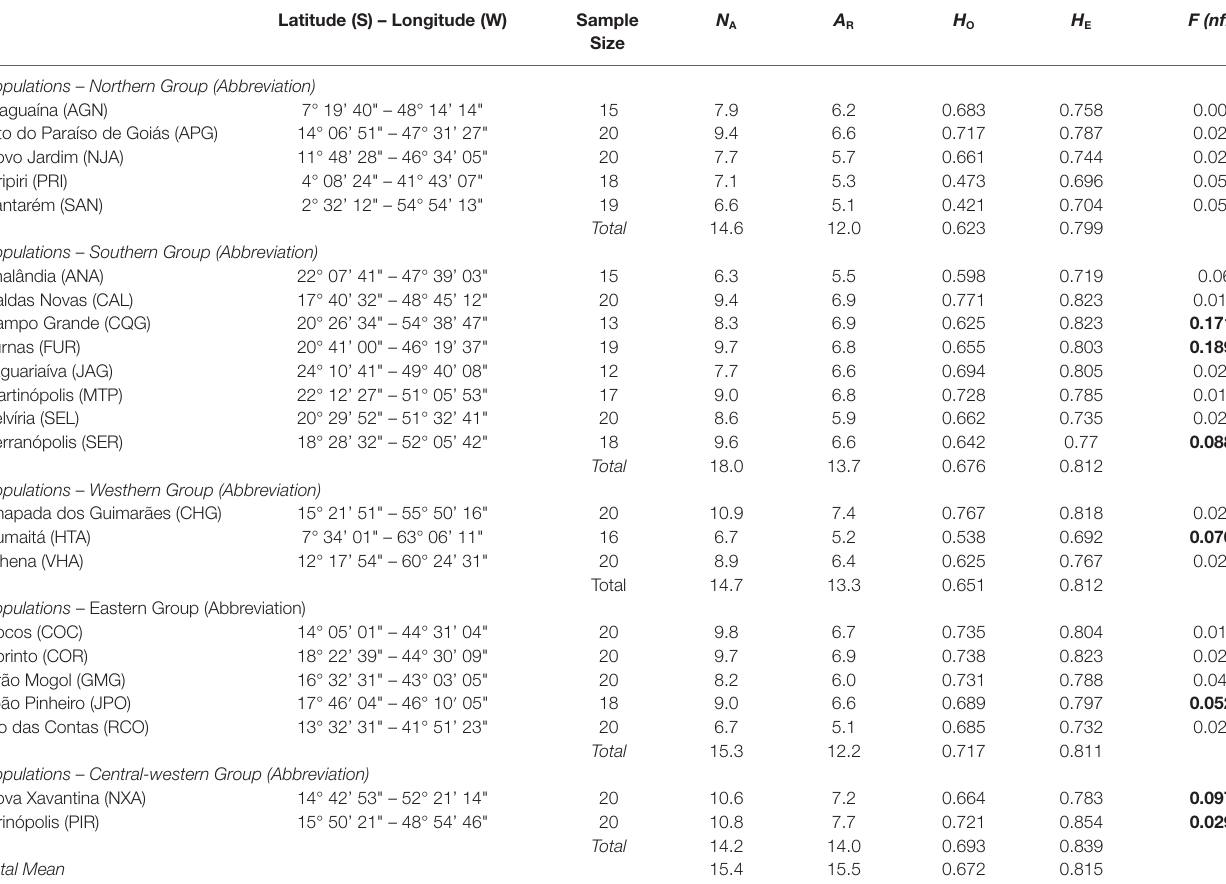
TABLE 1 | Genetic diversity and fixation indexes of Qualea grandiflora populations based on nine microsatellites markers. Latitude (S) – Longitude (W) Sample